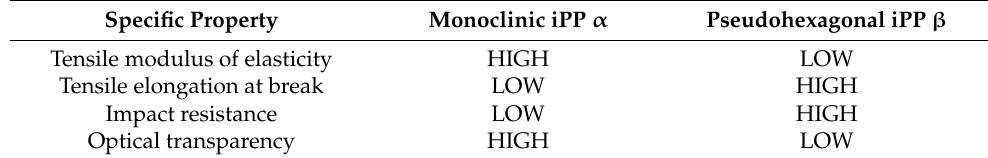
Table 1. Mechanical properties and transparency of α –phase iPP comparing with β –form samples. Specific Property Tensile modulus of elasticity HIGH LOW Tensile elongation at break LOW HIGH Impact resistance LOW Optical transparency HIGH